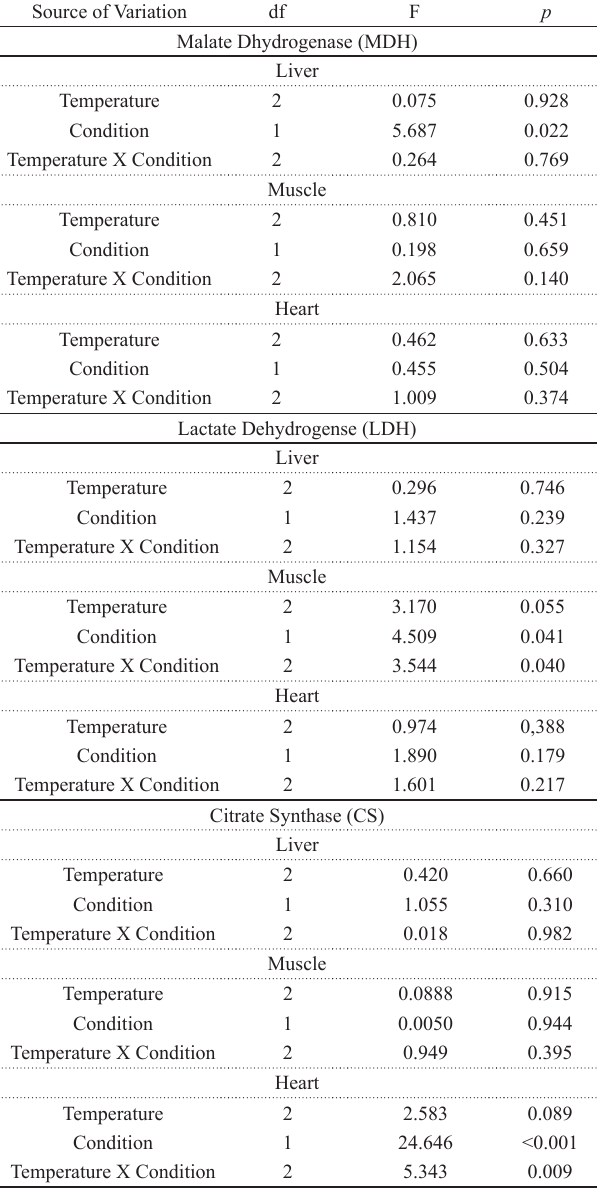
greater energy requirements, glycogen is rapidly used for the maintenance of basal functions and to supply anaerobic metabolism, thus reducing its concentration in tissues (Chippari-Gomes et al ., 2005). At lower temperatures fish may improve their hypoxia tolerance because of the reduced energy consumption and high concentration of glycogen (Yang et al ., 2015). The significant reduction of glycogen in the liver under hypoxic conditions at highest temperatures (24°C and 28°C) corroborates this